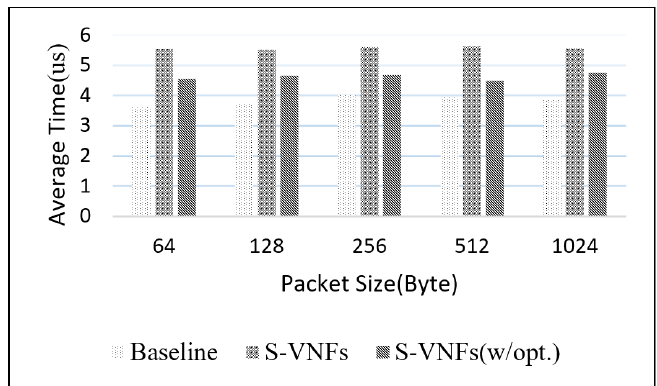
Figure 7. Average running time of the system at different packet